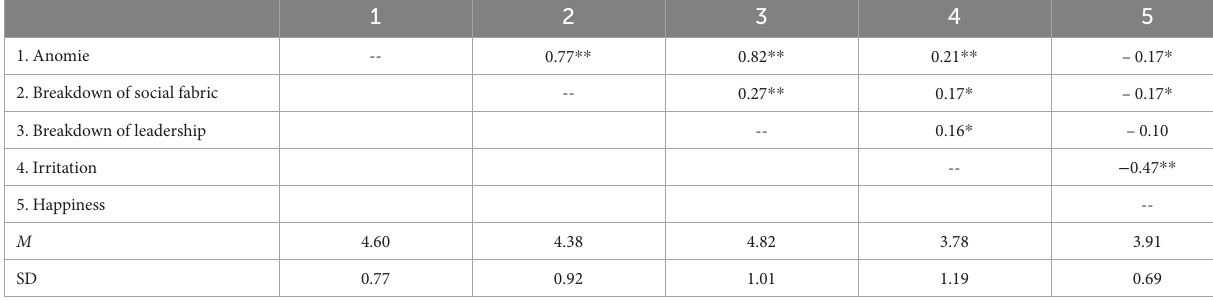
TABLE 1 Descriptive statistics and inter-correlations between anomie and its core dimensions, irritation, and happiness.